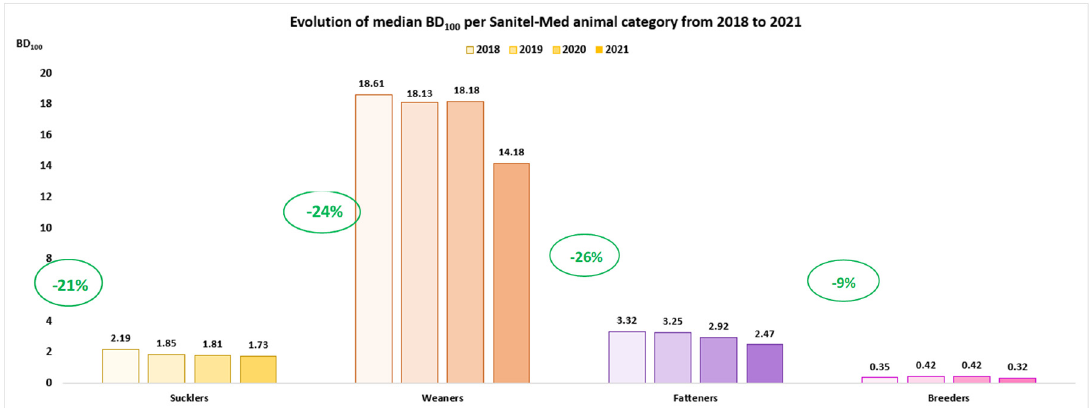
Figure 4. Evolution of the median of the BD100*-distribution in the reference populations for 2018, 2019, 2020, and 2021 of each Sanitel-Med pig category. Zero-use farms per year were excluded for the analysis. (BelVetSac 2021) [53]. *BD100 stands for “behandeldagen per 100 dagen” which is the Dutch equivalent of the treatment incidence per 100 days at risk.